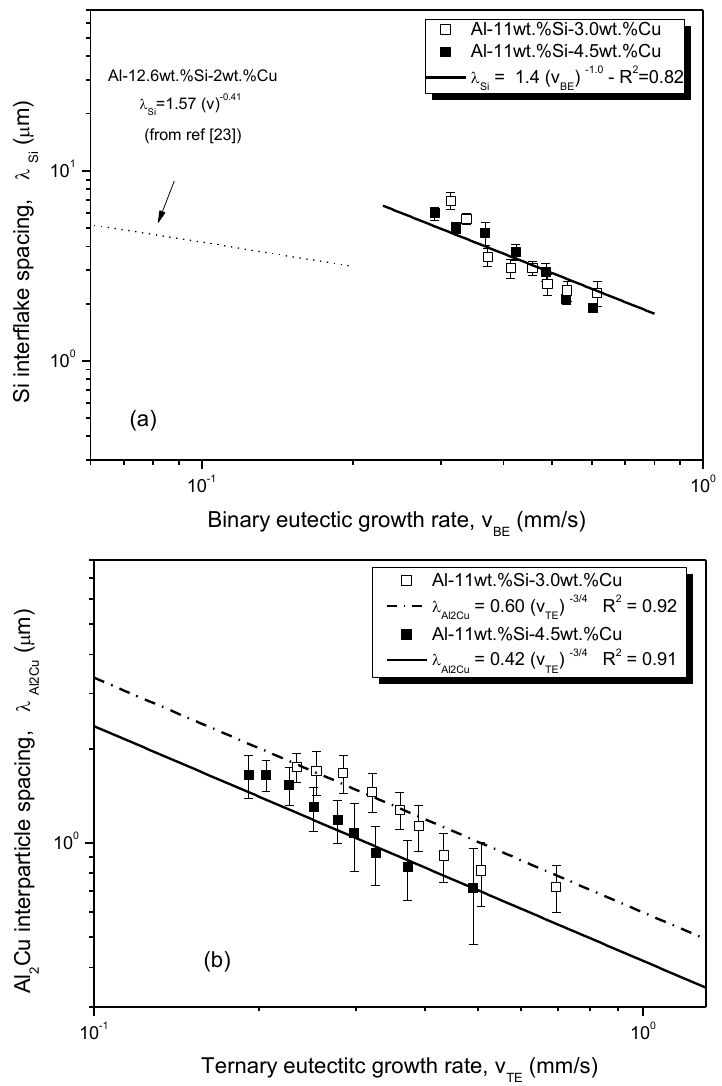
Figure 16. Experimental variations characterizing: ( a ) Si interflake spacing, λ Si , vs. eutectic growth velocity and ( b ) Al 2 Cu inter-particle spacing vs. eutectic growth velocity of the Al-11wt %Si- x wt %Cu alloys. R 2 is the coefficient of determination.